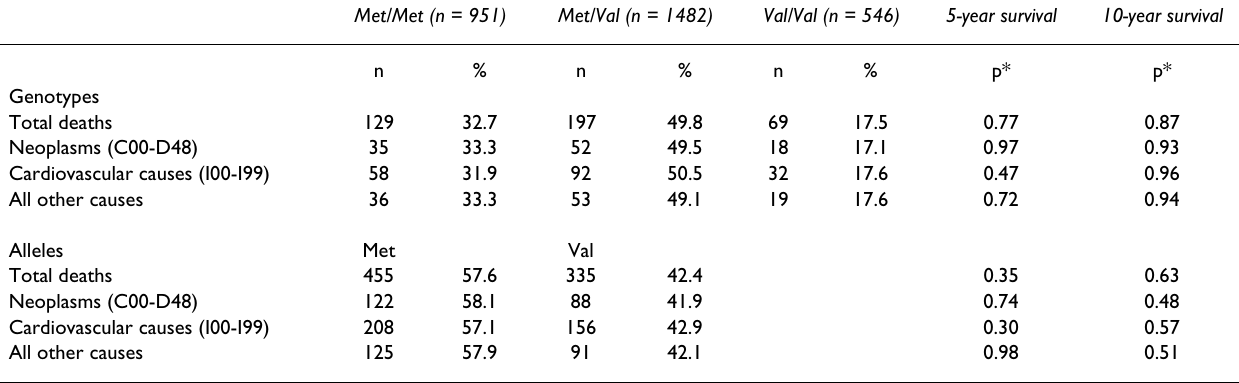
Table 3: Mortality from various causes by January 1, 2005 related to COMT genotypes and 5- and 10-year survival. Met/Met (n =